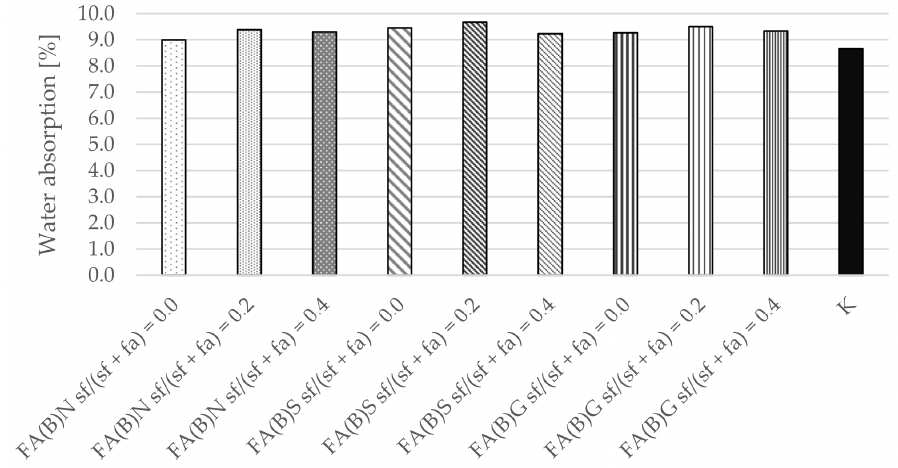
Figure 9. Water absorption of cement mortar with addition of activated and untreated fly ash. Similarly, the calculated results of density were similar between series, which indicate that despite the differences in water demand between different fly ash compositions and their activation method, the workability of specimens were not affected and remained comparable (Figure 10).